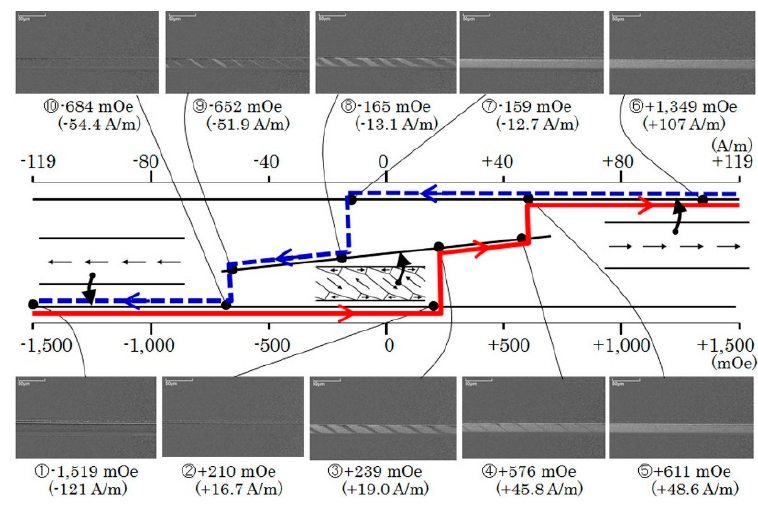
Figure 12. Detail of the domain transition for an element of easy axis θ = 67 ° .